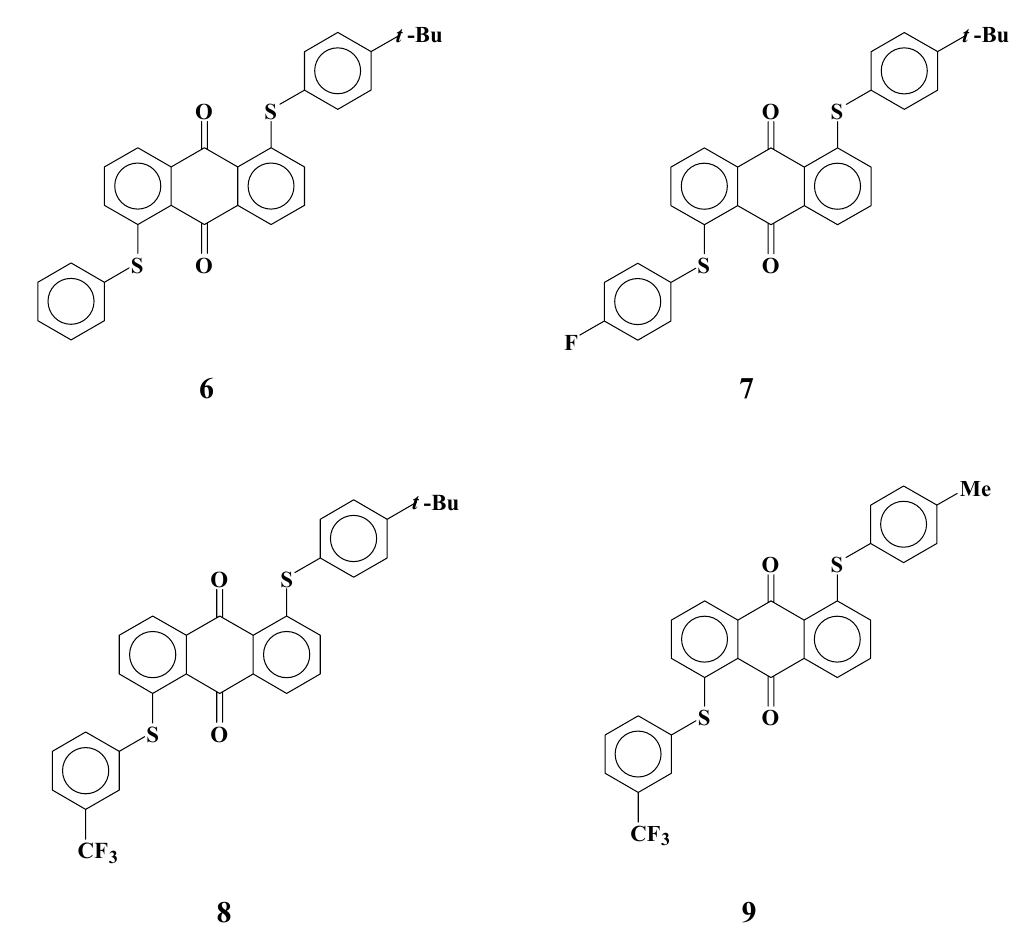
Figure 6. The molecular structures of yellow anthraquinone dyes with two different phenylthio groups at 1 and 5